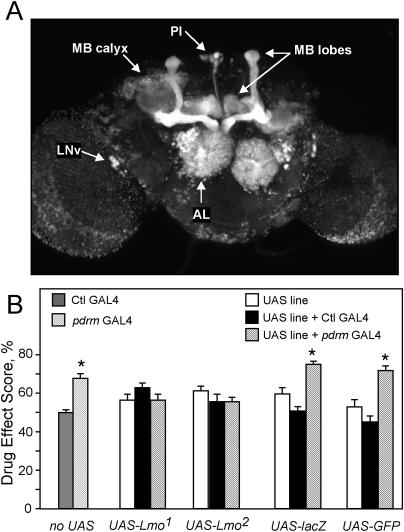

pdrm's GAL4 Expression Is Sufficient to Drive Lmo-Transgene-Mediated Rescue of Cocaine Sensitivity(A) pdrm's GAL4 expression pattern. UAS-GFP reveals GAL4 expression pattern of the pdrm enhancer-trap insertion in MB lobes and calyces, ALs, the large cell bodies of the peptidergic LNvs, and neurons of the pars intercerebralis (PI).(B) Lmo expression restores wild-type cocaine responses. In the absence of a UAS transgene (“no UAS” columns), hemizygous male pdrm flies (hatched bar) are more sensitive than controls (Ctl GAL4 is line 8.142, solid bar), as shown before in Figure 1A. Male flies hemizygous for pdrm and heterozygous for either of two UAS-Lmo transgenes (UAS-Lmo1 and UAS-Lmo2; hatched black bars), show normal cocaine sensitivity when compared to either UAS-Lmo transgene alone (white bars) or UAS-Lmo transgenes in the presence of a control GAL4 line (Ctl GAL4, line 8.142; black bars). To control for non-specific effects of transgene overexpression, UAS-GFP and UAS-lacZ transgenes were also driven by pdrm GAL4. Male flies were hemizygous for pdrm (or heterozygous for the control GAL4 insertion) and heterozygous for the specific UAS transgene. One-way ANOVA revealed a significant effect of genotype in the UAS-lacZ (F = 17.4, p < 0.001), UAS-GFP (F = 19.47, p < 0.001), or no UAS transgene (F = 4.1, p < 0.001) groups, but not in either of the UAS-Lmo transgene groups (F = 1.58, p = 0.22 and F = 1.21, p = 0.31 for UAS-Lmo1 and UAS-LMO2, respectively); thus, UAS-Lmo expression specifically restores normal cocaine sensitivity to pdrm flies. Post hoc pairwise planned comparisons, with the critical p-value adjusted to 0.025, revealed significant differences between the “non-rescued” pdrm/UAS-GFP flies and the appropriate controls (UAS-GFP/+ or 8.142/UAS-GFP, p < 0.002); similarly, pdrm/UAS-lacZ flies are significantly different from their controls (UAS-lacZ/+ and 8.142/UAS-lacZ, p < 0.002). Pairwise comparisons revealed no significant differences between “rescued” pdrm/UAS-Lmo1 flies and their “normal” controls (8.142/UAS-Lmo1 and UAS-Lmo1/+, p = 0.99 and p = 0.14, respectively) or pdrm/UAS-Lmo2 flies and their controls (8.142/UAS-Lmo2/+ and UAS-Lmo2/+, p = 0.09 and p = 0.99, respectively), indicating full rescue of pdrm cocaine sensitivity. For all genotypes, n = 16–20 experiments.